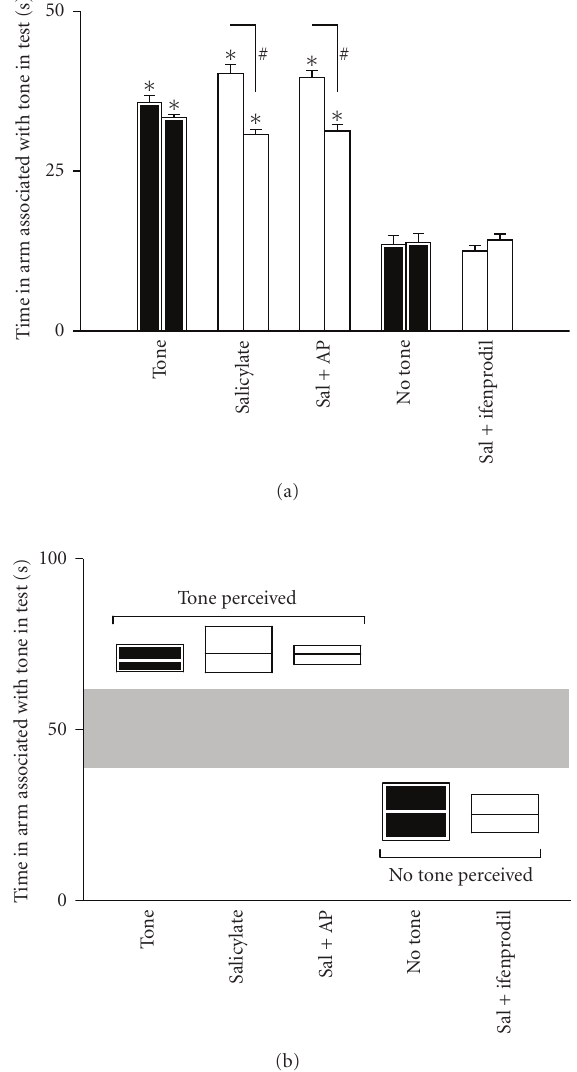
Figure 2: Induction of tinnitus by salicylate (sal), its blockade by NR2B antagonist (ifneprodil), and establishment of behavioral criteria for tinnitus. (a) Time spent in the tone arm during the test . The time spent by various treatment-groups (identified along the X -axis) in the tone arm during the first 50 seconds (left-hand bar in each pair) and the last 50 seconds of the test. Black bars refer to groups of animals which were tested after conditioning without any treatment. The test was performed two weeks after the end of conditioning. Rats tested in the presence of the tone displayed preference for the tone arm, whereas rats tested in the absence of the tone displayed preference for the no-tone arm. Salicylate-treated rats (300 mg/kg/day for 4 consecutive days, the last injection taking place 2 hours before the test) behaved as if they perceive a tone, spending most of their time in the tone arm though the tone was absent. Cochlear application of artificial perilymph (AP) had no e ff ect, but cochlear application of ifenprodil reversed the behavior induced by salicylate ( ∗ P < .01 from animals tested in silence, # P < .01 from the first 50 seconds window of the same group ( n = 8 each)). (b) Definition of the criteria used to designate rats as experiencing tinnitus. Rats were designated as perceiving a tone in its absence, that is, su ff ering from tinnitus, if in the WTM test in the absence of the tone they spent in the tone arm not less than 2 SD ( P > .05) below the mean time spent by untreated conditioned rats, tested in the presence of the tone, in the tone arm. Similarly, treated rats were designated as lacking tinnitus if in the test they spent in the tone arm not more than 2 SD above the mean time spent by untreated conditioned rats, tested in the absence of the tone, in the tone arm (the separation of the two possible behavioral patterns generated according to the aforementioned criteria is emphasized by the grey zone). These criteria were used to designate rats as experiencing tinnitus in the noise-induced tinnitus